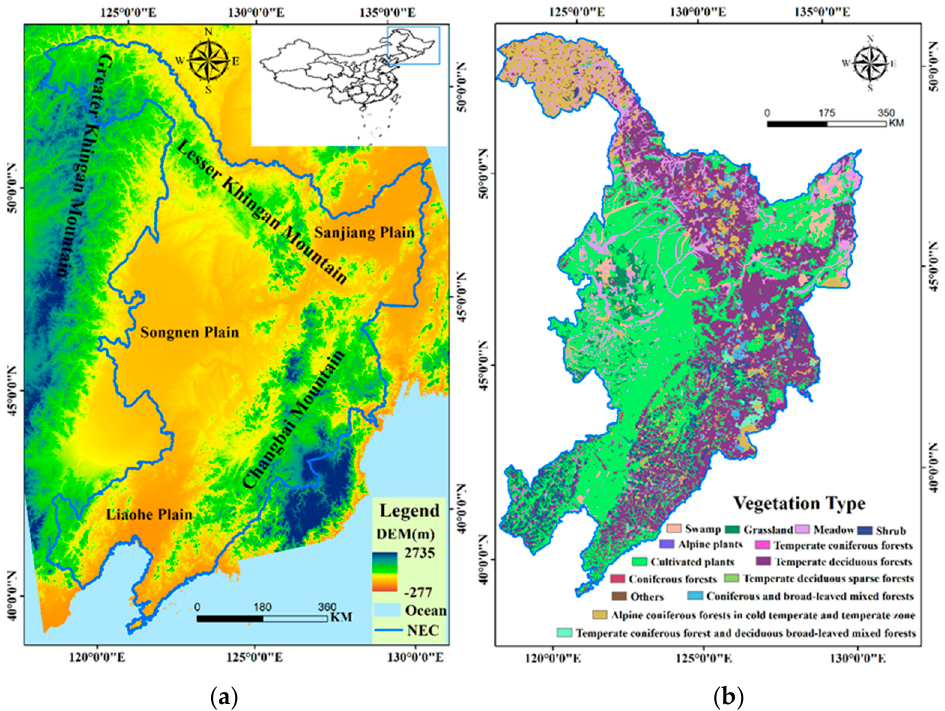
Figure 1. ( a ) Location of the study area with elevation from a Digital Elevation Model (DEM) and ( b ) Vegetation types of the Northeast China (NEC). (Vegetation type is provided by the Moderate Resolution Imaging Spectroradiometer (MODIS) MCD12Q1 datasets [38] in 2015).